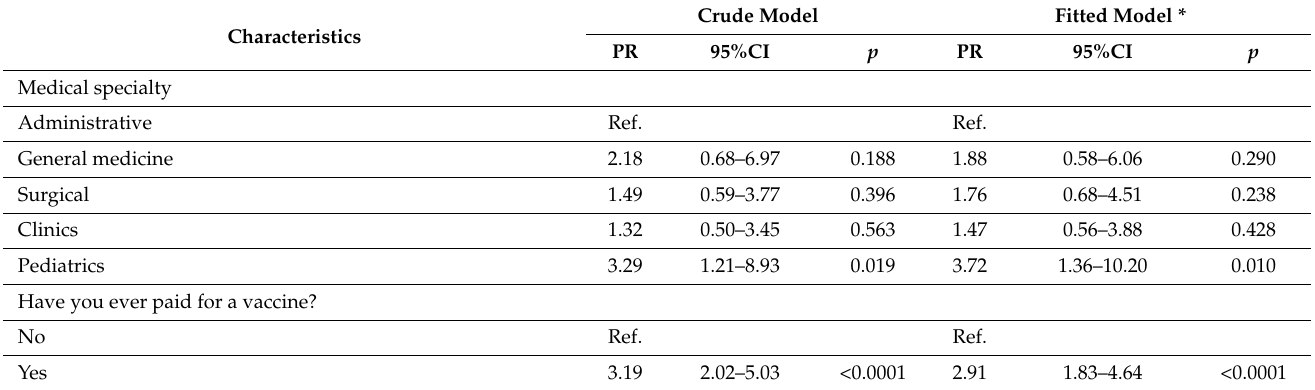
Table 3. Variables associated with the acceptance of free vaccination with an effectiveness of